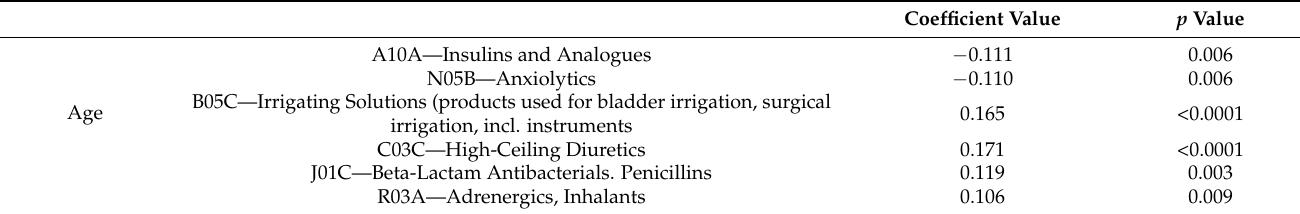
Table 4. Spearman correlation between age and medicines prescribed (third level, pharmacological subgroup).